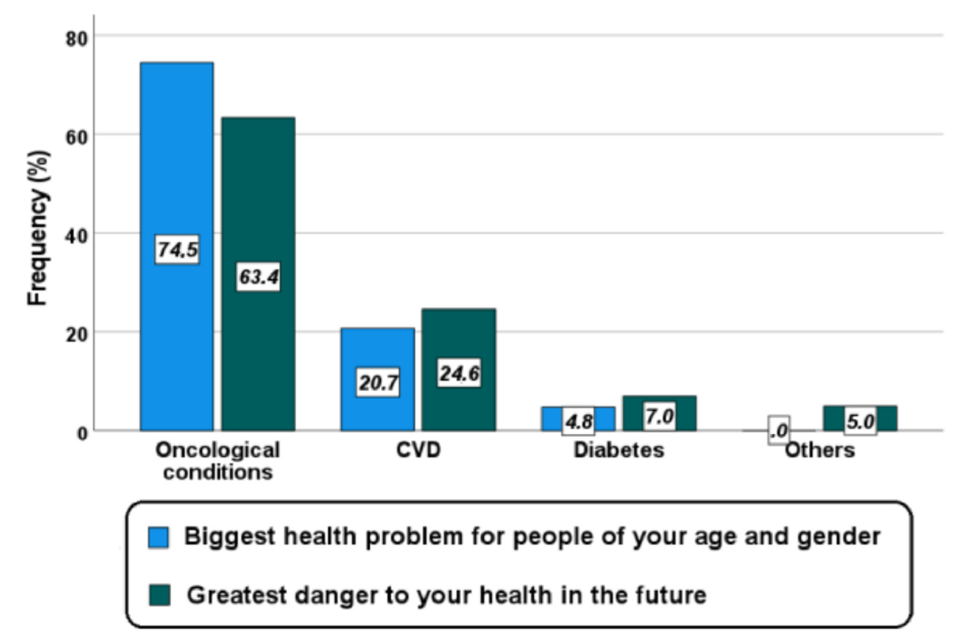
Figure 2. Percent response to the multiple choice questions “What is the biggest health problem for people of your age and gender and what is the greatest danger to your health in the future?”.